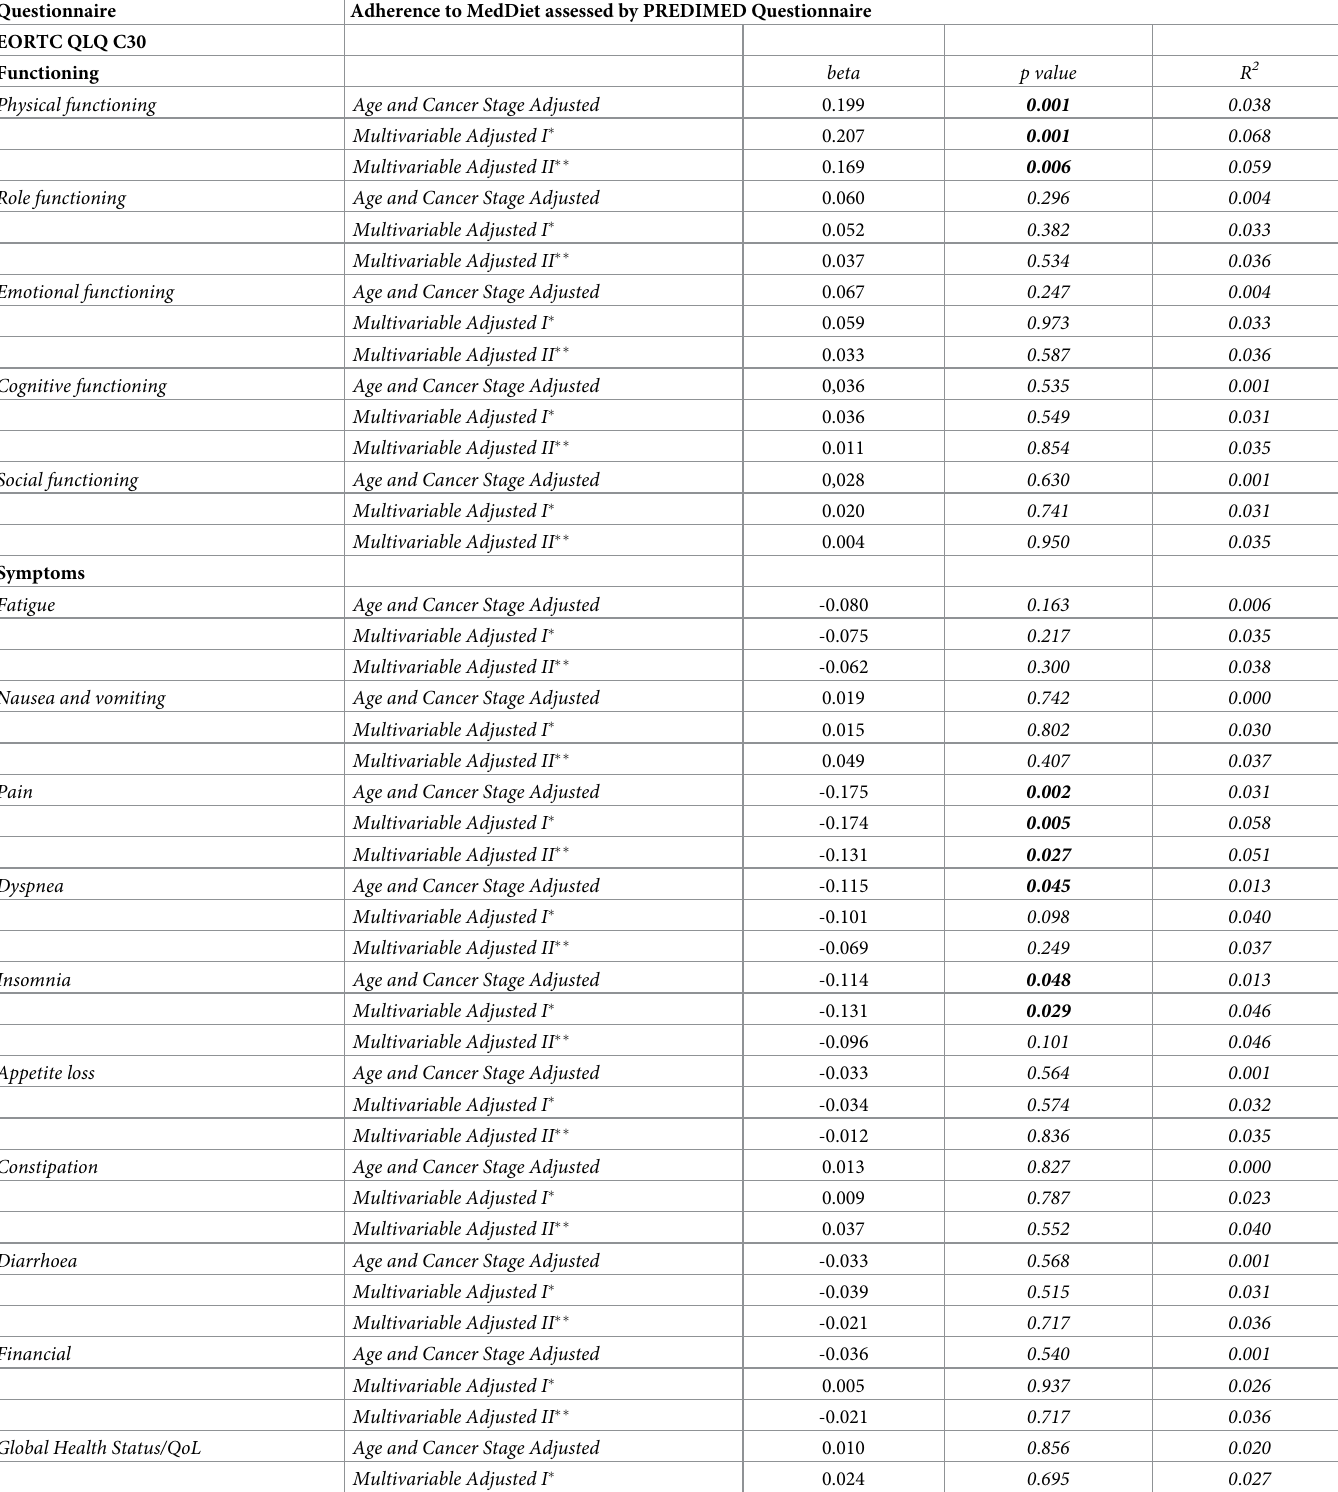
Table 4. Association between adherence to the Mediterranean Diet (MedDiet) and HRQoL questionnaires EORTC QLQ-C30.